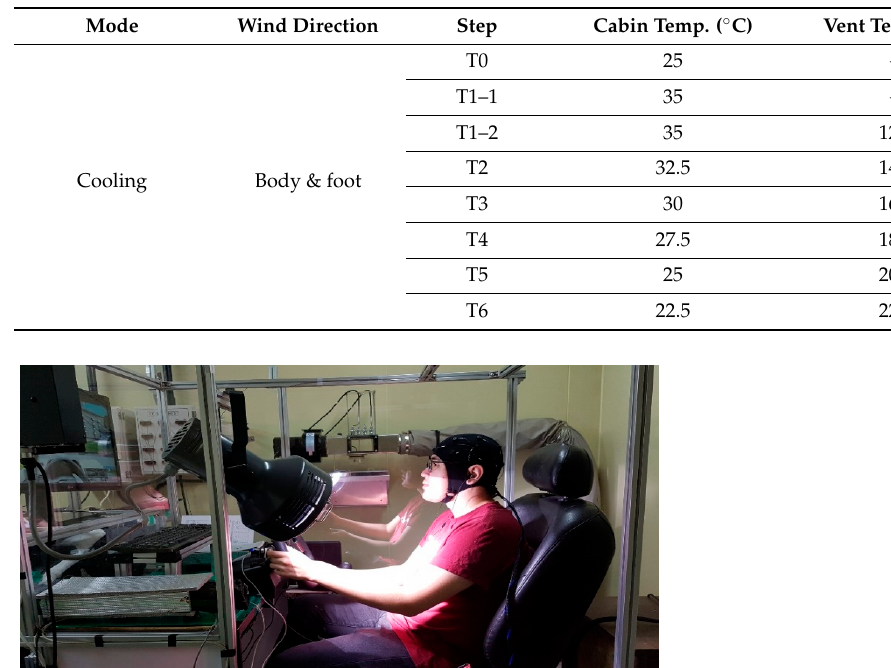
Table 9. Setting temperature for cooling mode.